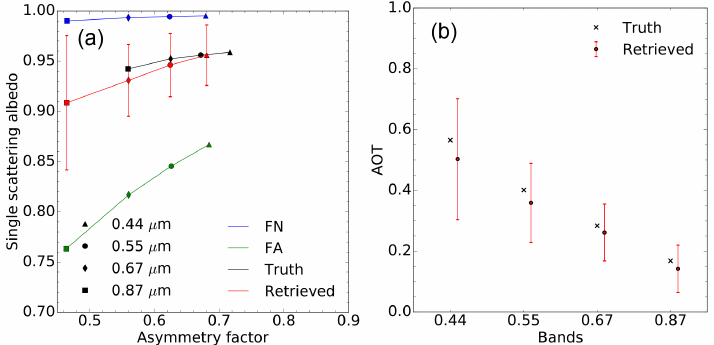
Figure 6. Same as Fig. 5 but for experiment F10.